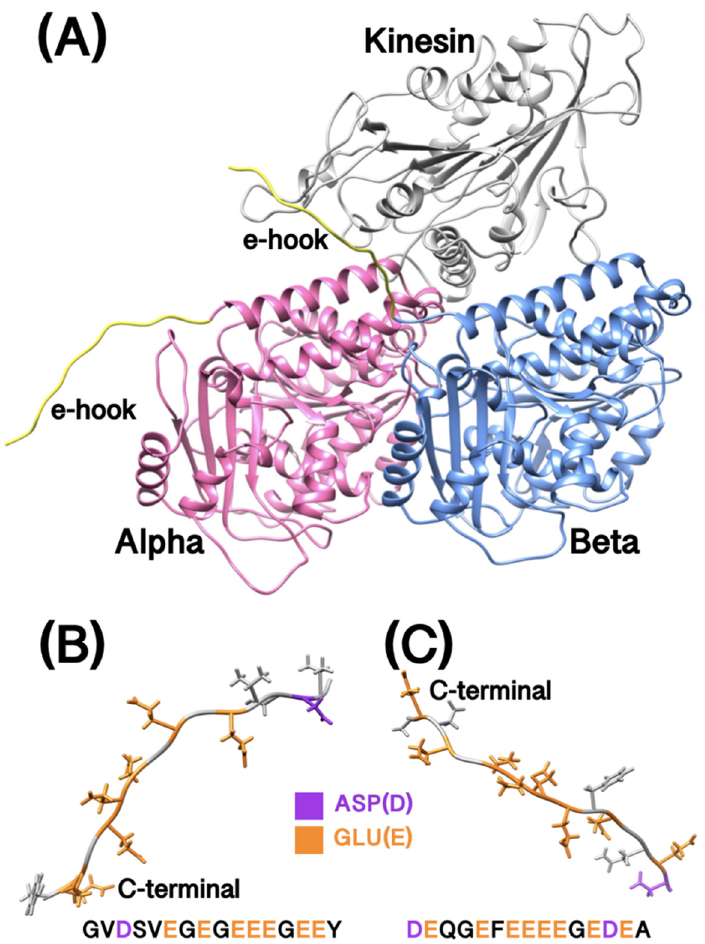
Figure 1. The complex structure of kinesin and tubulins with E-hooks. ( A ) The structure of kinesin and tubulins with E-hooks. Alpha tubulin is colored in pink, beta tubulin is colored in blue and kinesin is colored in grey. E-hooks in both alpha and beta tubulins are colored in yellow; ( B ) Alpha tubulin E-hook with the sequence details; ( C ) Beta tubulin E-hook with the sequence details. In B and C, GLU is colored in orange, ASP is colored in purple and residues with no charge are colored in gray.